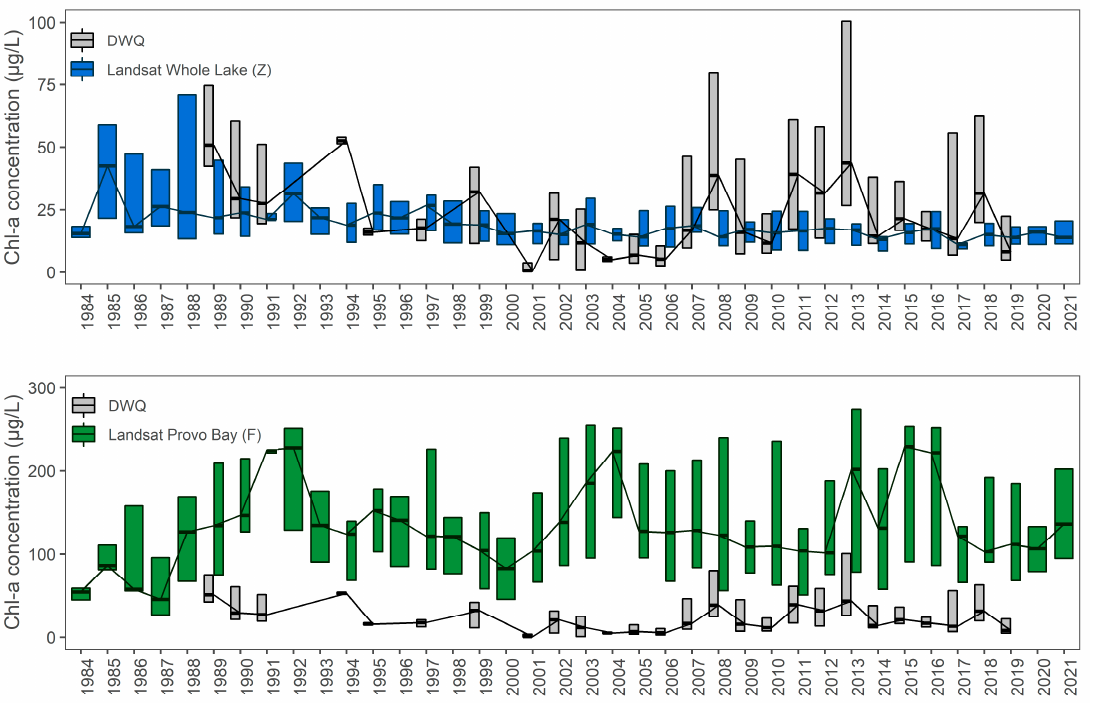
Figure 18. Comparison of Landsat chl-a estimates with DWQ data on chl-a in Utah Lake for our lake median ( top panel ) and Provo Bay median ( bottom panel ) with different scales. Our median lake data generally agree with the DWQ data, with DWQ being slightly higher because it is weighted towards locations with high chl-a content. The DWQ data lie between the median for the lake and Provo Bay, which we attribute to DWQ sample locations.